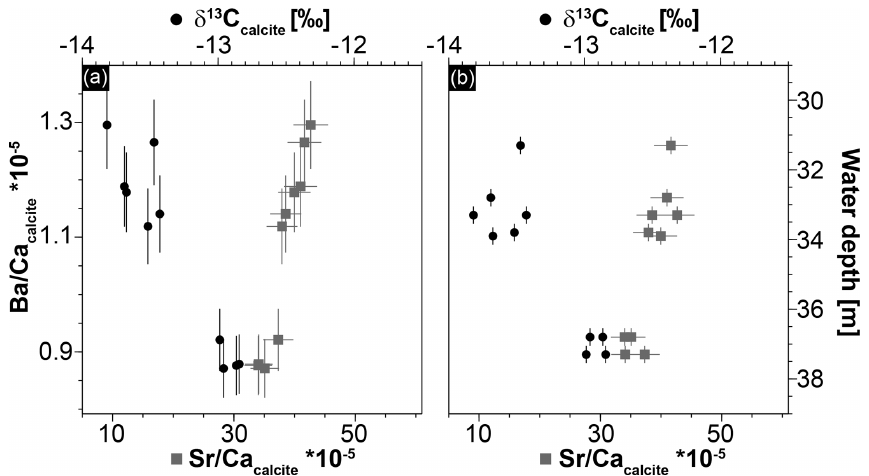
Figure 6. Geochemical data of Hells Bells speleothems showing a strong correlation between Sr / Ca and Ba / Ca ratios ( r 2 = 0 . 91) and between Ba / Ca and δ 13 C calcite ( r 2 = 0 . 89) (a) and a trend of increasing δ 13 C calcite and decreasing Sr / Ca with increasing water depth of the samples (b) . Given uncertainties represent 2 σ standard deviations and ± 0.25m is assumed as uncertainty for the water depth of the Hells Bells samples. Table 1. Geochemistry of samples from the lowermost tips of Hells Bells growing on a subfossil ceiba tree that fell into the El Zapote cenote about 3500calBP. Individual tree bells were sampled at water depths from 31.3 to 37.3m. The lack of samples in water depths from 34.3 to 36.8m water depth is due to poor visibility in the turbid layer above the halocline (compare Fig. 1b). Given uncertainties represent 2 σ standard